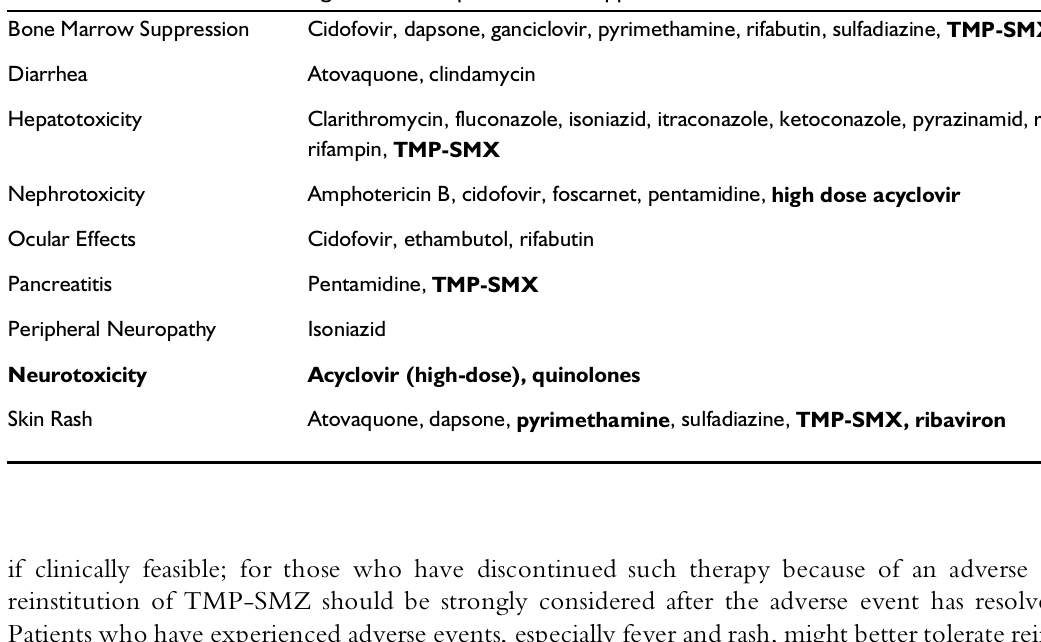
Table 7 Adverse effects of drugs used in the prevention of opportunistic